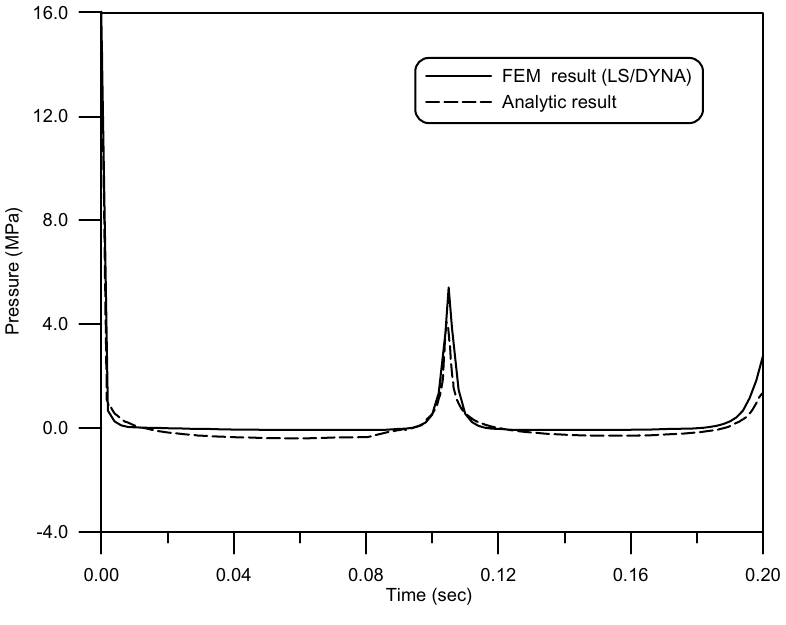
Fig. 6. Comparison of LS/DYNA and theoretical